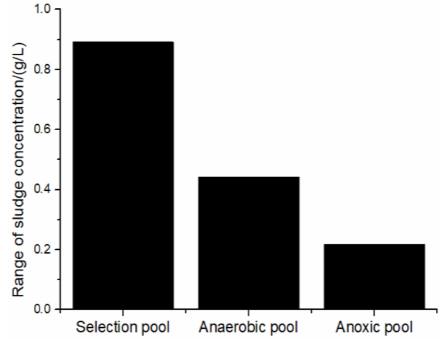
Figure 10. Range of sludge